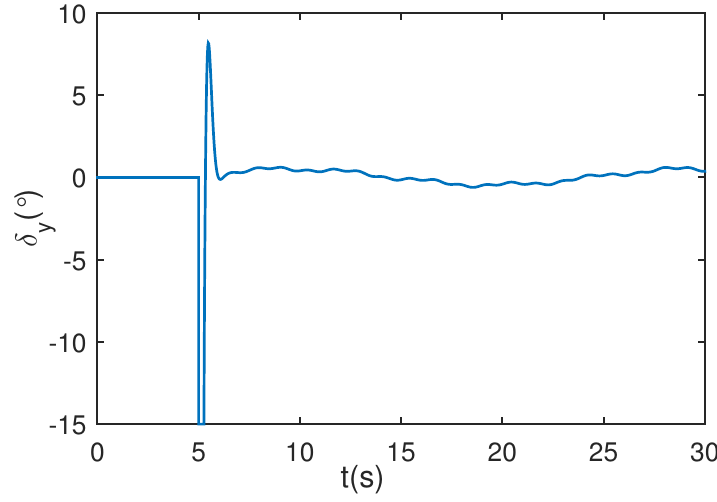
Figure 14. The lateral thrust vectoring angle output in attitude